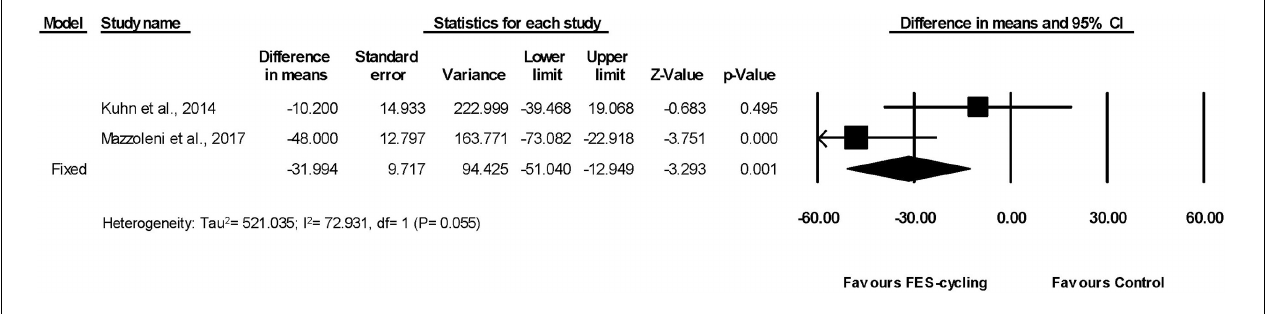
FIGURE 7 | A forest plot of Timed Up and Go (TUG) after FES-cycling training.